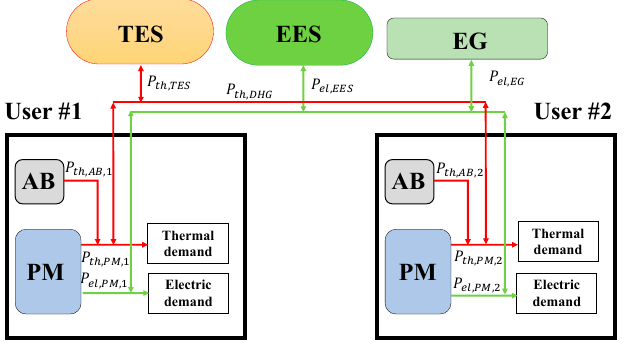
Figure 3. CHP scenario with shared TES and EES.